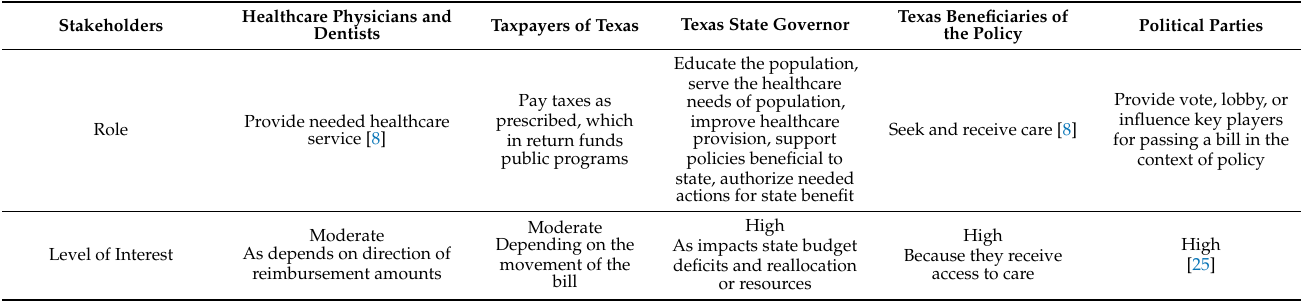
Table 1. Key critics and influencers for determining opposition of legislation regarding preventive dental service coverage in